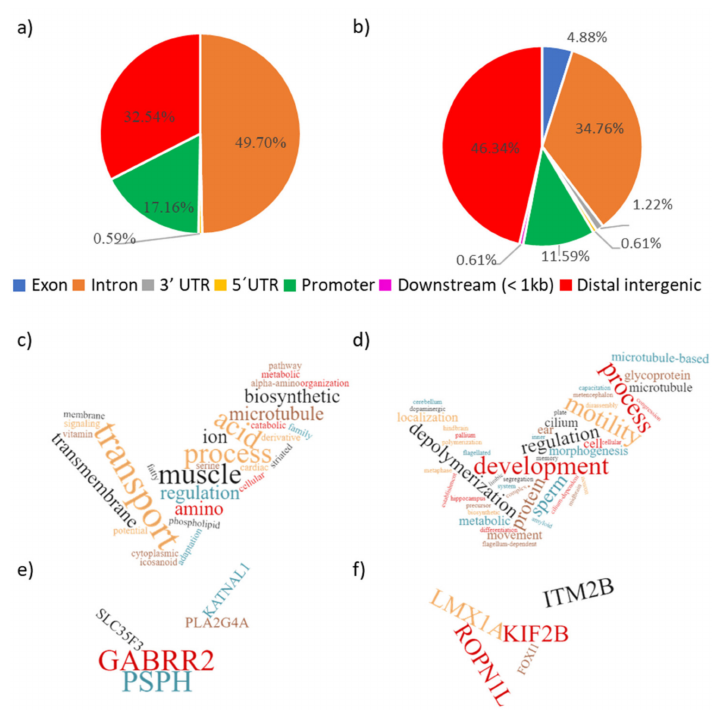
Figure 5. ( a – f ). Pie charts representing the functional annotation of the significant ( a ) SNPs and ( b ) DMRs, identified between HF and LF experimental boar groups. The work clouds represent the most frequent words that showed up though the significant Gene Ontology (GO)-pathways (adj p ≤ 0.2) of enriched genes related to the significant SNPs ( c ) and the DMRs ( d ); while the most frequent genes related with the identified pathways appear in ( e ) for SNPs and in ( f ) for